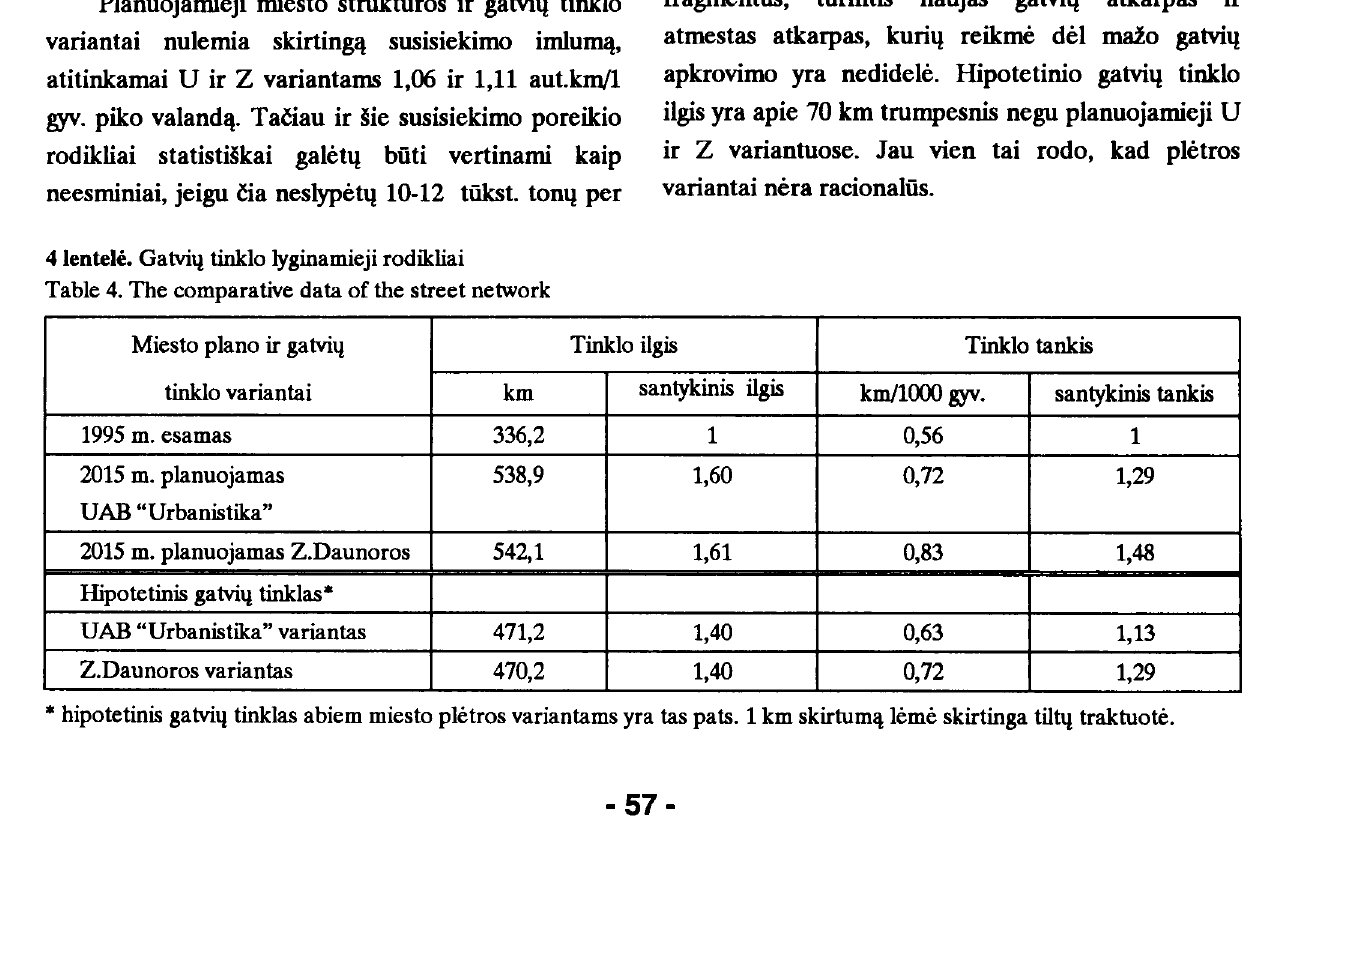
Vilniaus miesto plano variantams, buvo sudacytas hipotetinis